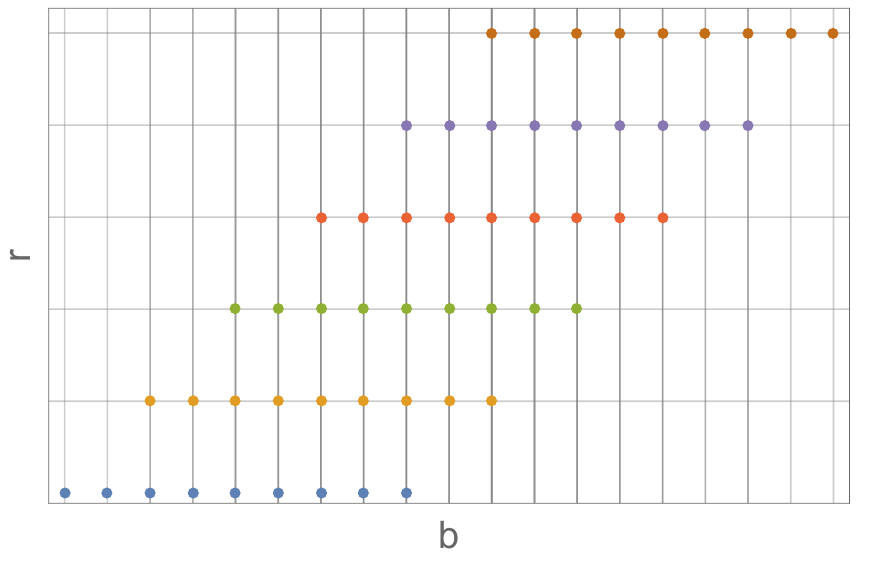
Figure 1 . A representation of all operators with the same g s scaling, organized according to their level of non-locality, r (vertical axis) and M p scaling, b (horizontal axis). In the time dependent case, each level of non-locality only has finitely many operators, each with different M p dependence. For σ 3 ( r ) = 0 changing non-locality level shifts the M p scalings, resulting in a finite number of operators on each vertical line, i.e. with a given M p